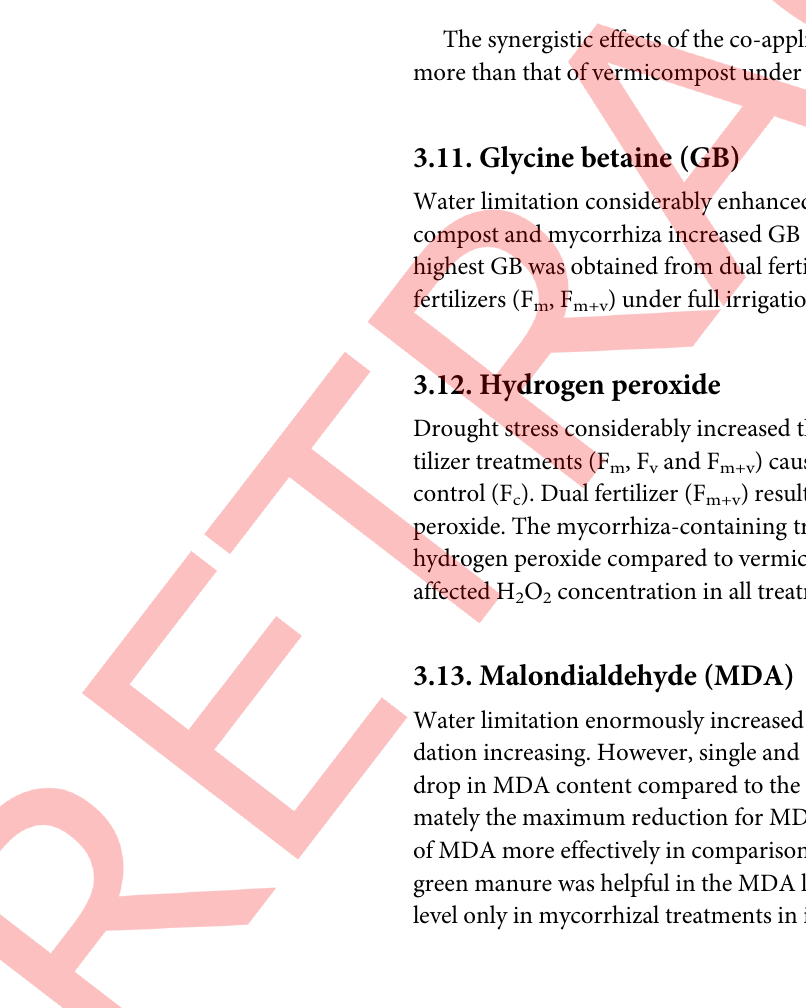
Fig 2. Interaction of green manure and irrigation regimes on superoxide dismutase